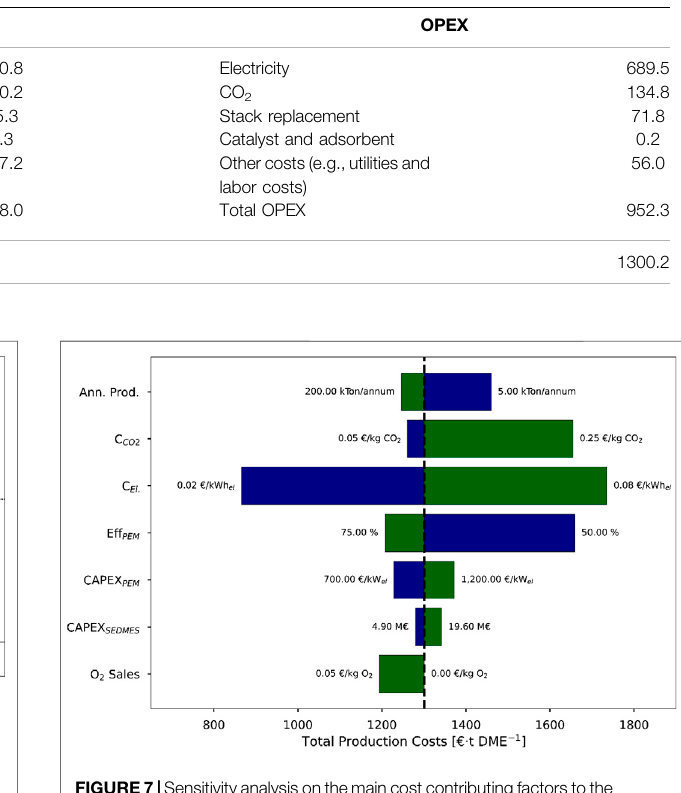
FIGURE 6 | Waterfall chart showing the main cost contributions to the production cost for a ton of DME using the power-to-X technology SEDMES process.